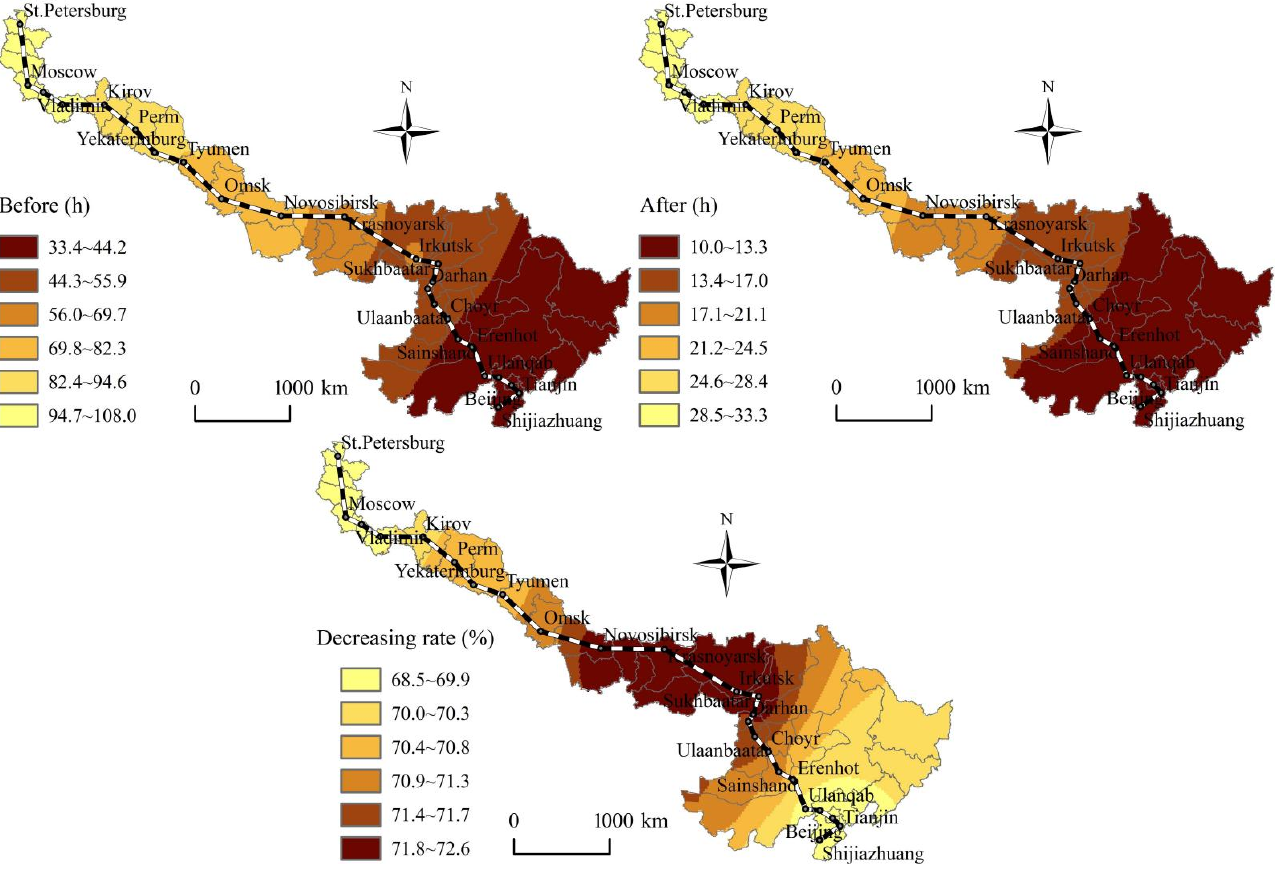
Figure 2. Spatial pattern changes of the weighted average travel time before and after the China- Mongolia-Russia HSR west line